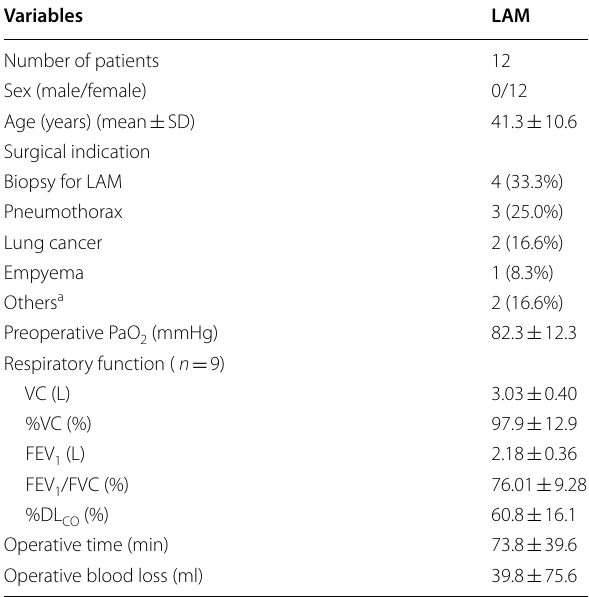
Table 1 Clinical characteristics of study